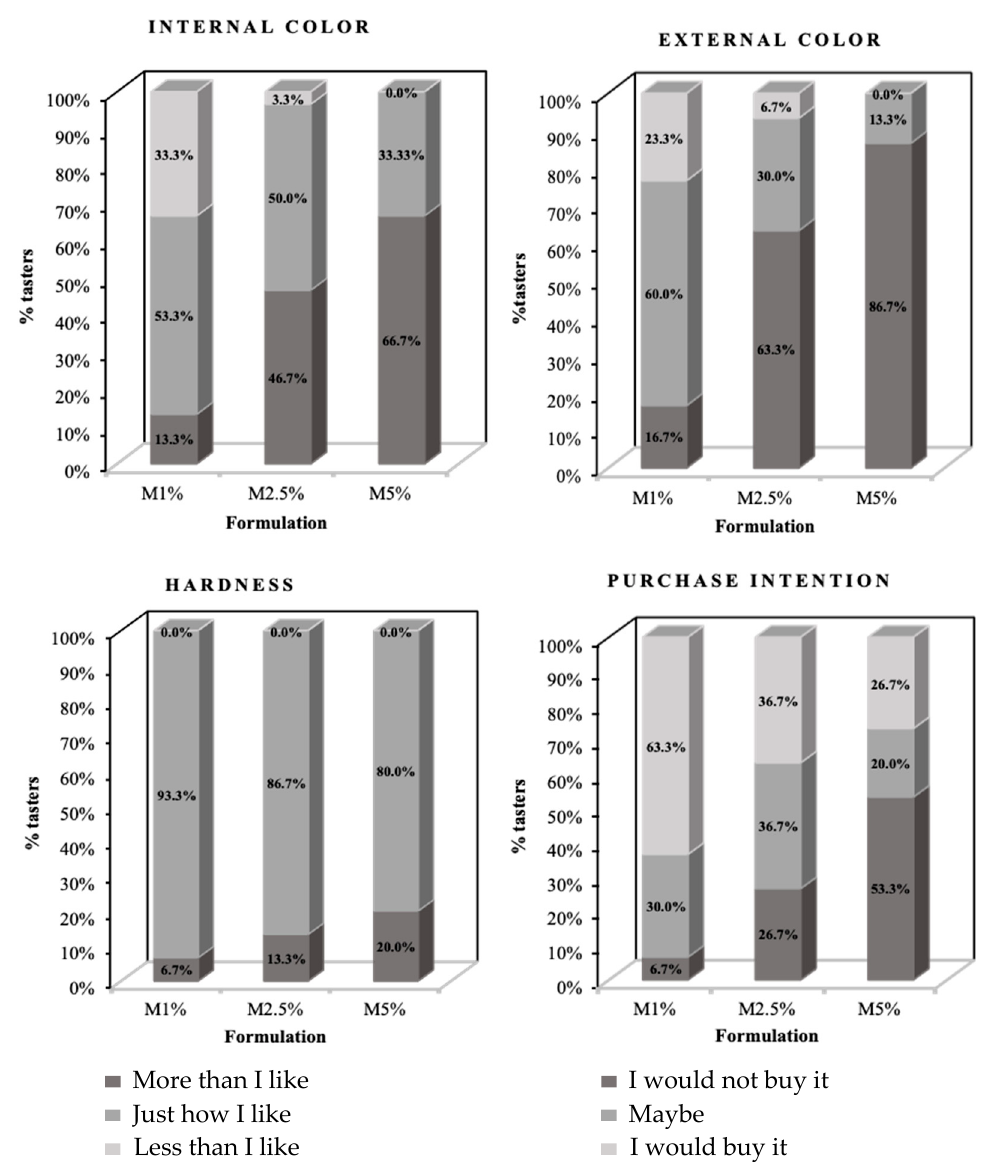
Figure 2. Just about right assessment (JAR) of cupcakes formulated with